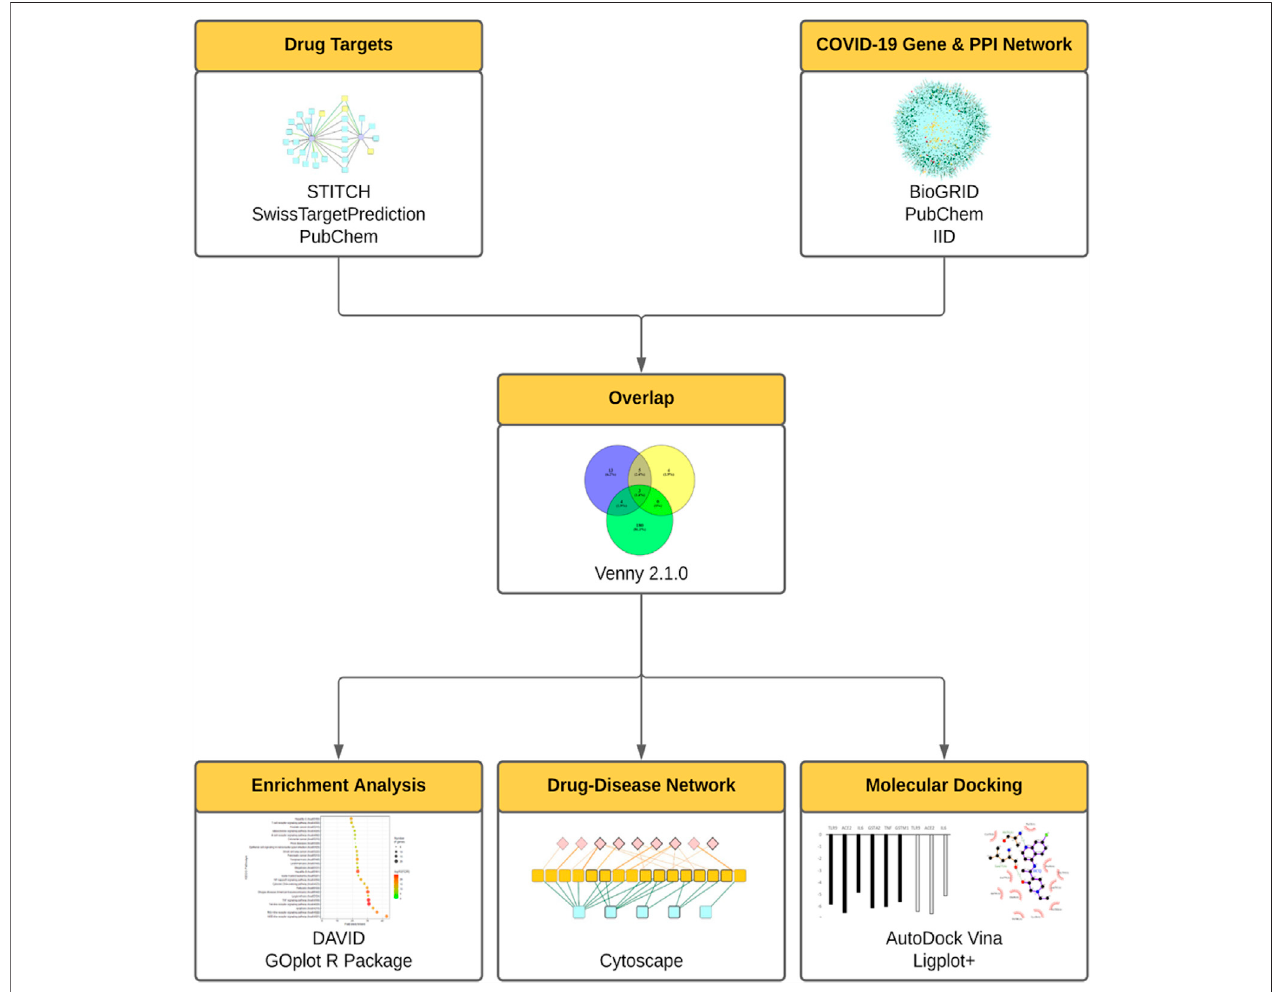
FIGURE 1 | The integrative framework for the assessment of repurposed drugs for COVID-19 treatment. In this framework, drug targets were assessed using STITCH, SwissTarget, PubChem. COVID-19 gene and protein networks were analyzed using PubChem, BioGRID, IID. Then the derived drug targets and gene/protein networks were overlapped (using Venny 2.1.0), then subject to enrichment analysis (DAVID, GOplot R Package), drug-disease network (Cytoscape), molecular docking analyses (AutoDock